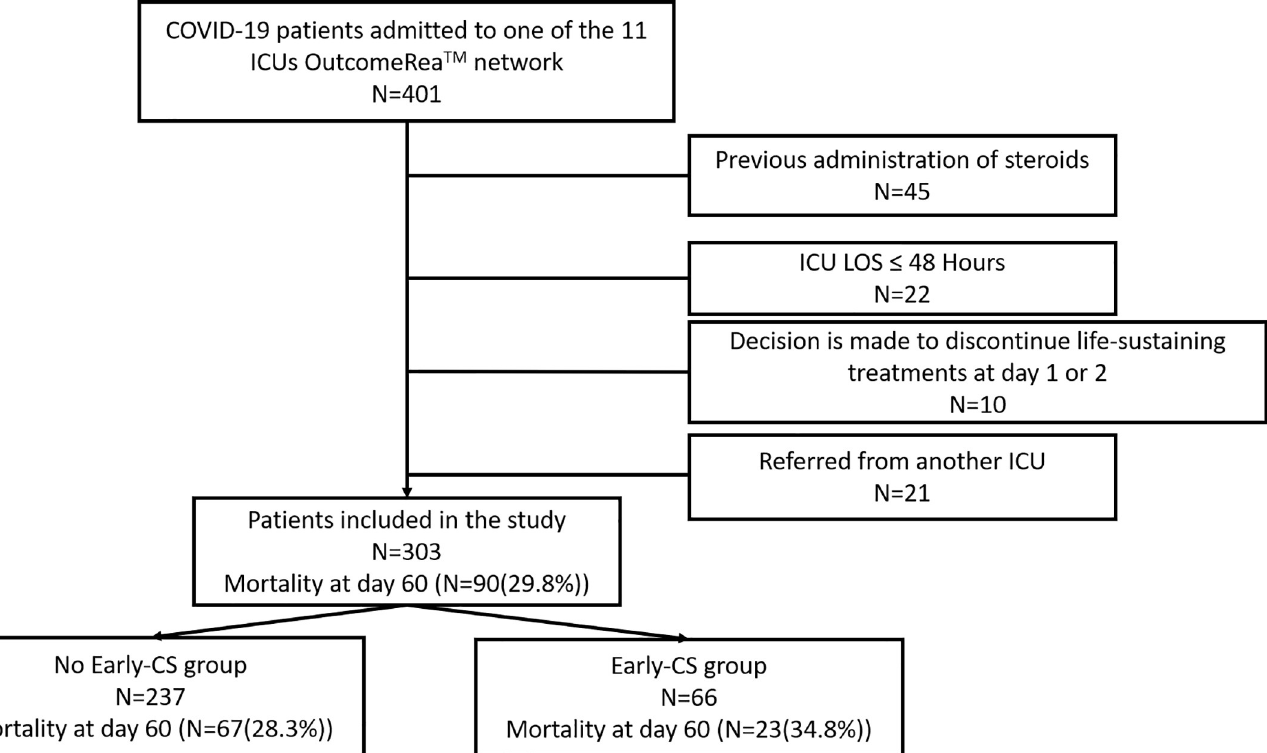
PLOS ONE | https://doi.org/10.1371/journal.pone.0255644 August 4,